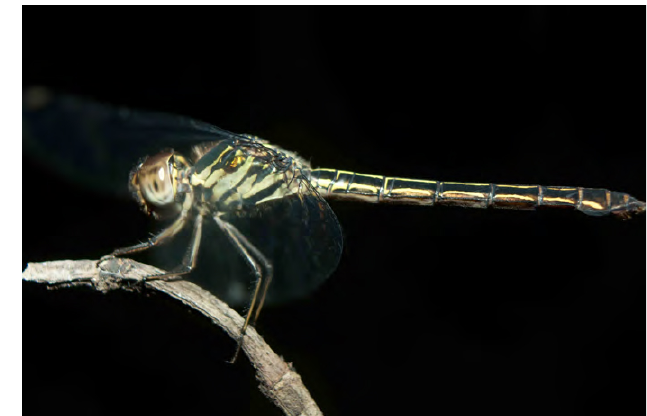
Figure 19. Cratilla lineata calverti ♀ .